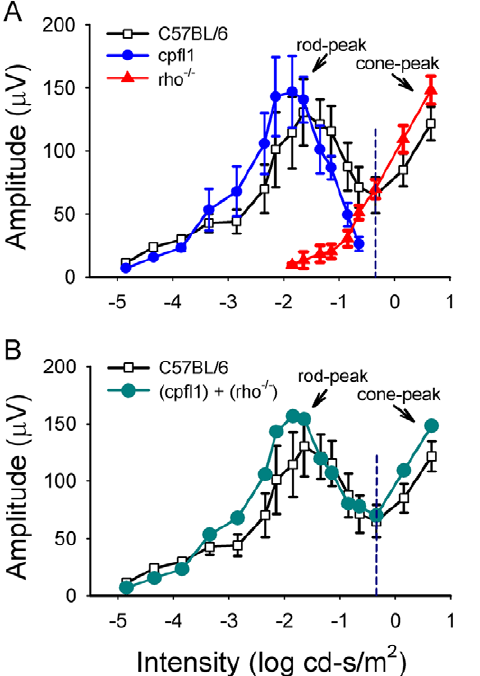
Figure 3. Dark-adapted 10-Hz flicker ERG response amplitude- intensity profiles in C57BL/6 , cpfl1 and rho 2 / 2 mice. There are two peaks in the wild-type mice, with the first representing rod-driven and the second representing cone-driven responses (Panel A). In cpfl1 (n=5) mice, the rod peak still exists while the cone peak is absent. In rho 2 / 2 (n=4) mice the rod peak is absent, but the cone peak persists. The summation of the amplitude-intensity curves of the flicker ERG responses in rho 2 / 2 and cpfl1 mice mimics the profile of the C57BL/6 (n=5) mice. (Panel B. Bars indicate the standard deviation.).